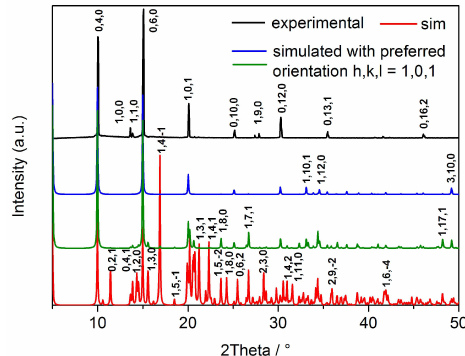
Figure 6. Comparison of the experimental PXRD pattern of 2 ( black ) with the unconstrained simulated pattern from the X-ray data ( red ) and simulated patterns with the preferred orientation of h , k , l = 1, 0, 1 and March–Dollase parameter = 4 ( green ) and = 10 ( blue ). The latter simulations try to take into account the rod-shaped crystal morphology of 2 with their non-random orientation on the flat sample holder. The Miller indices have been assigned to the reflections. Simulations were carried out with Mercury